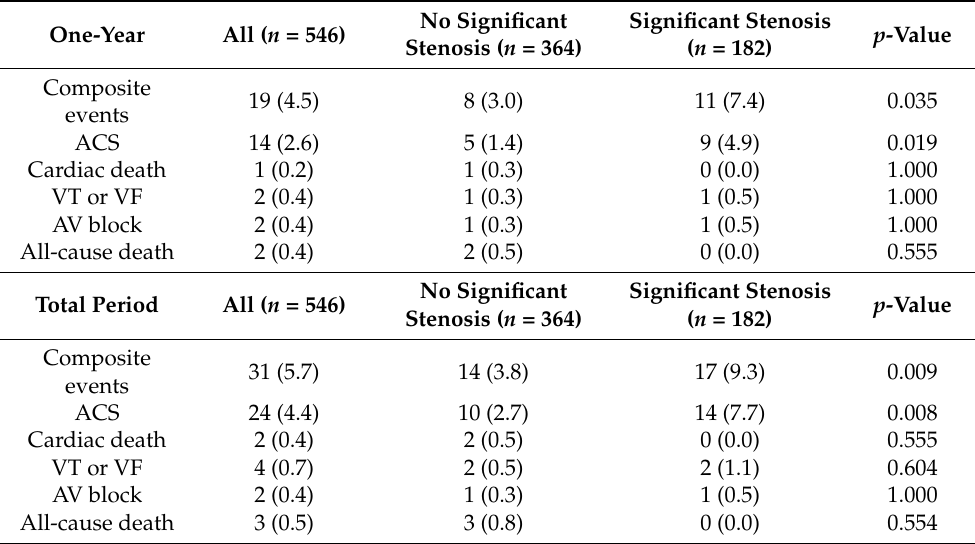
Table 4. Clinical event rate of patients with VA according to significant stenosis of coronary artery in matched